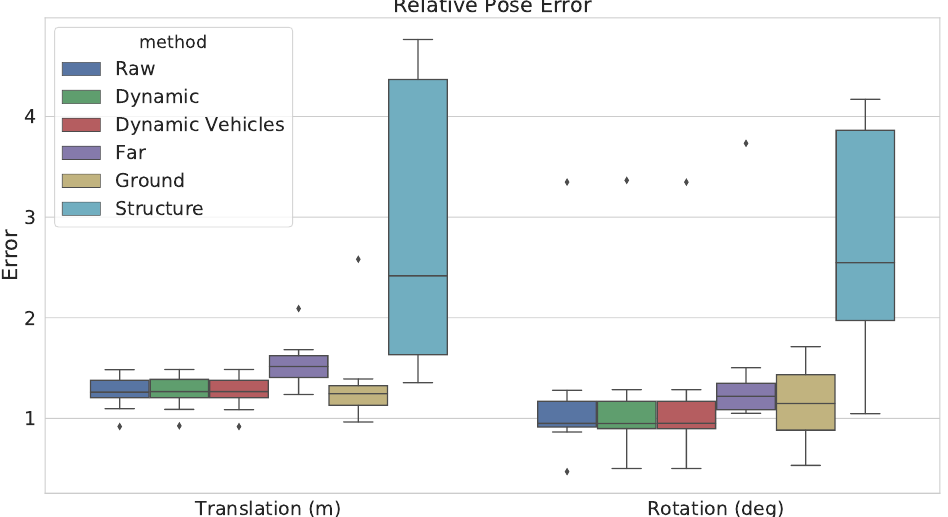
Figure 3. Distribution of the RPE (in translation and rotation) across all the KITTI odometry sequences with ground truth available for each input configuration.